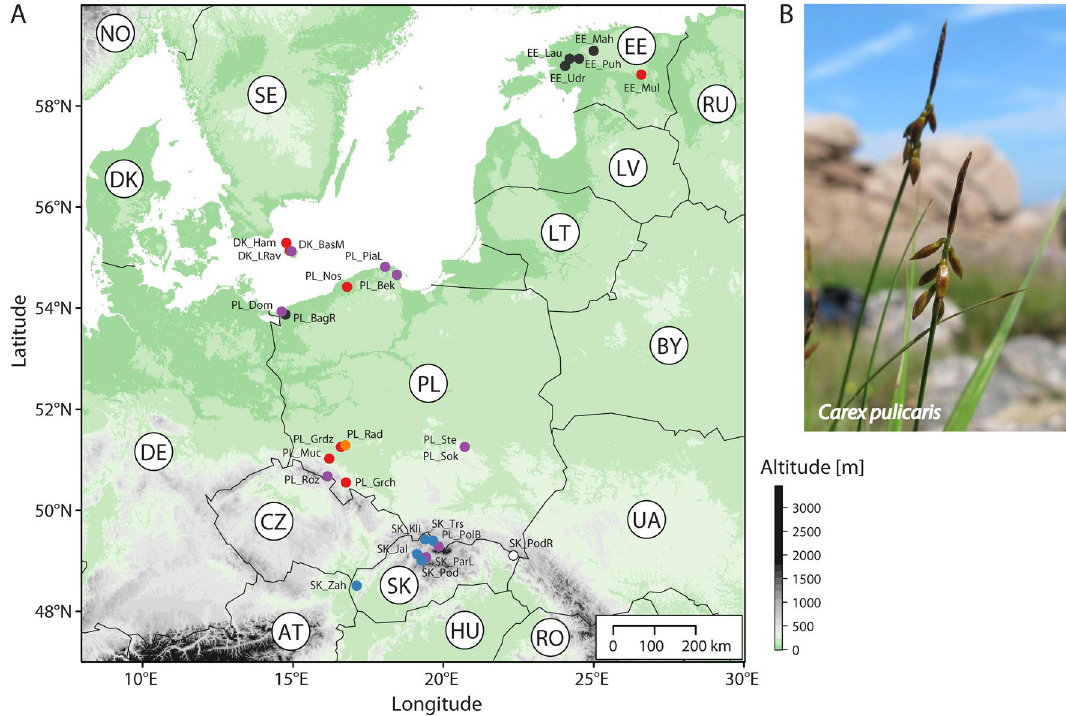
Figure 1. Survey of investigated localities with the occurrence of Carex pulicaris . ( A ) Distribution map of sampled sites, colouring according to plant communities as inferred in the present study; ( B ) Carex pulicaris (photo: Grzegorz Grzejszczak). Countries are indicated using two-letter ISO 3166-1 alpha-2 codes. Locality abbreviations follow Table 1. Colouring of symbols: black—Estonian group, blue—Slovakian group, orange— Radecz group, purple—Ambiguous group, red—Polish group, white—locality in Slovakia with the occurence of C. pulicaris , but lacks species composition